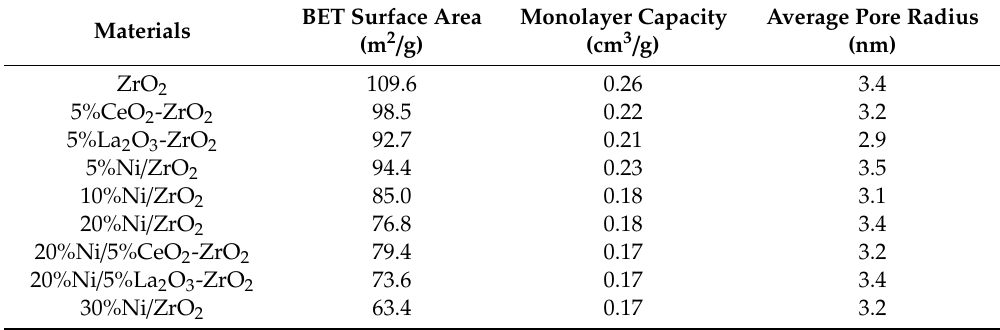
Table 4. Specific surface area and pore size distributions of support and monometallic Ni-supported catalysts calcined in an air atmosphere at 400 ◦ C for 4